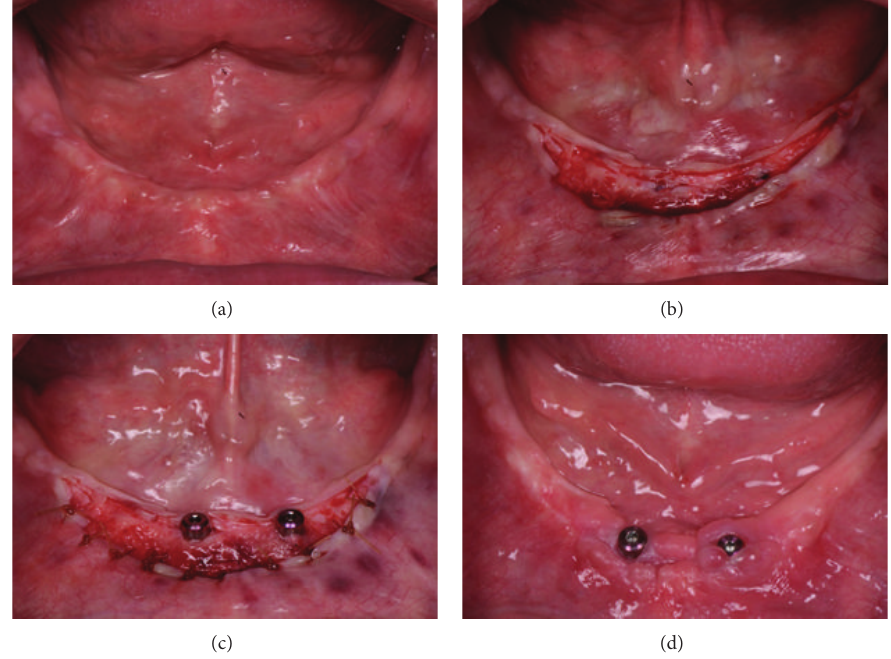
Figure 2: (a) Presurgical appearance of mandibular ridge with 0-1mm of keratinized tissue. (b) Partial thickness flap reflection. (c) Apical suturing of the flap to the periosteum using Chromic Gut 4.0. (d) Final result after the surgery showed a 2-3 mm increase in keratinized